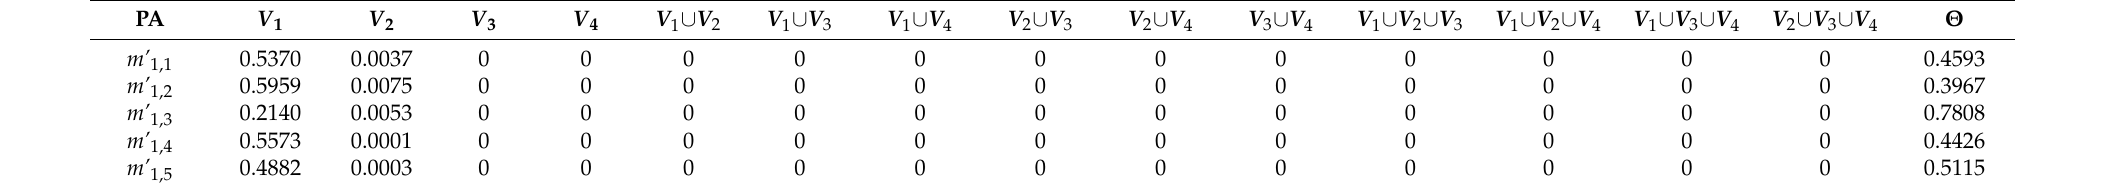
Table 11. Probability assignments of without crack-longitudinal crack sub-classifier for an image of transverse crack.